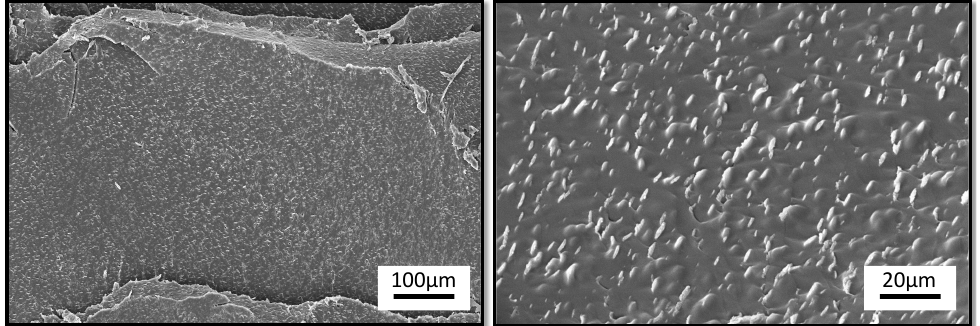
Table 4. DMA parameters obtained for extruded Humins-DA, together with the respective healing efficiencies at both 60 and 80 °C for 1 h.